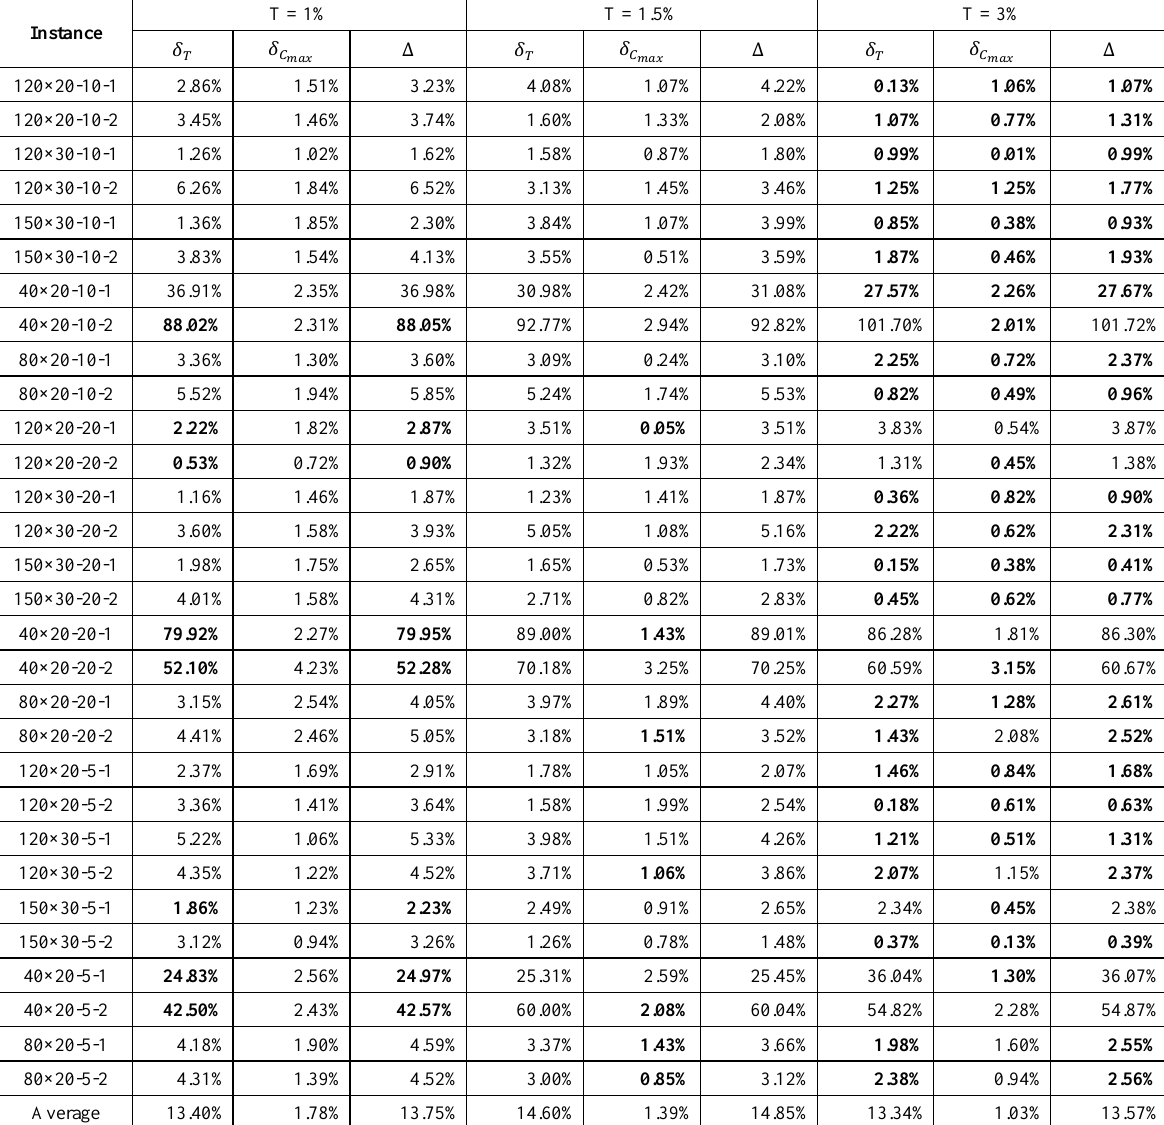
Table 4. Distance of the best trade-off solution obtained with MOEA/D to the ideal